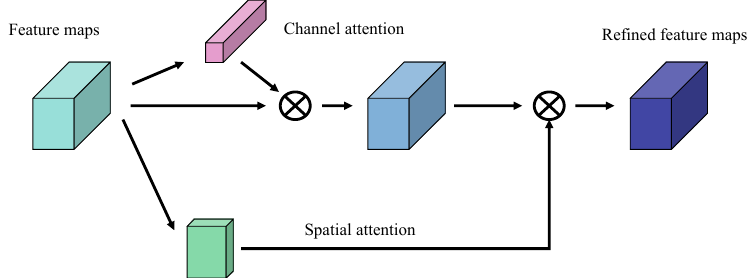
Figure 7. The CBAM module is structured as